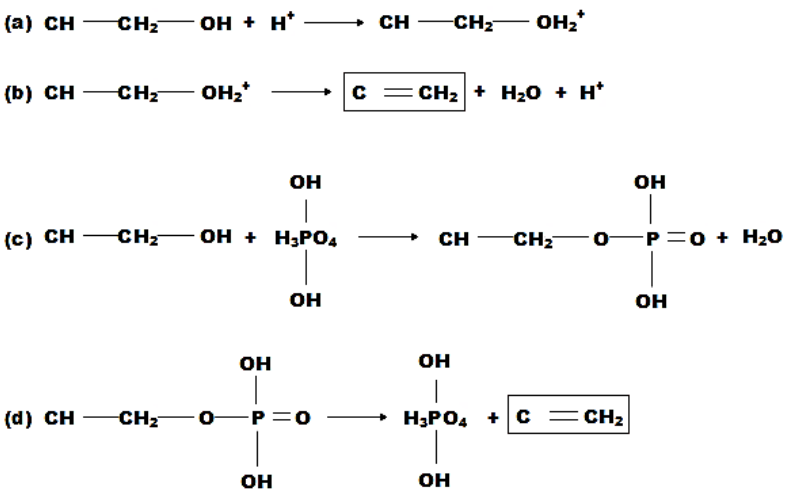
Figure 7. General mechanisms of intumescent flame retardant coatings.